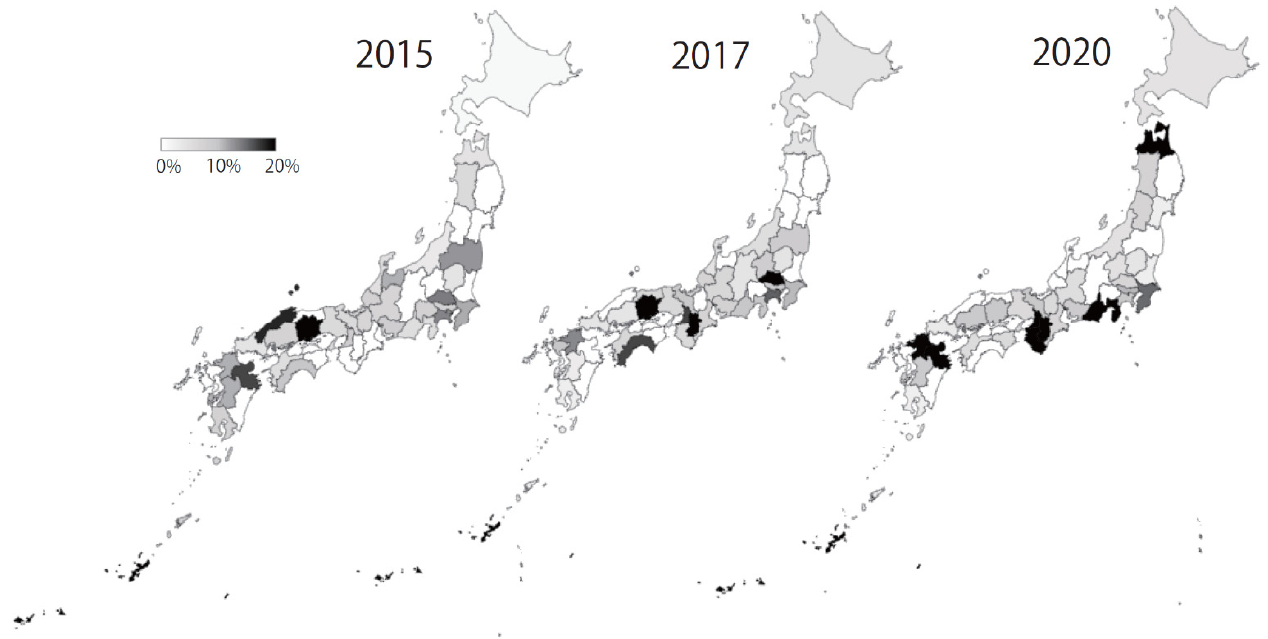
Figure 6. Proportion of hospitals with VRE isolates among JANIS participating hospitals based on prefecture level, 2015,